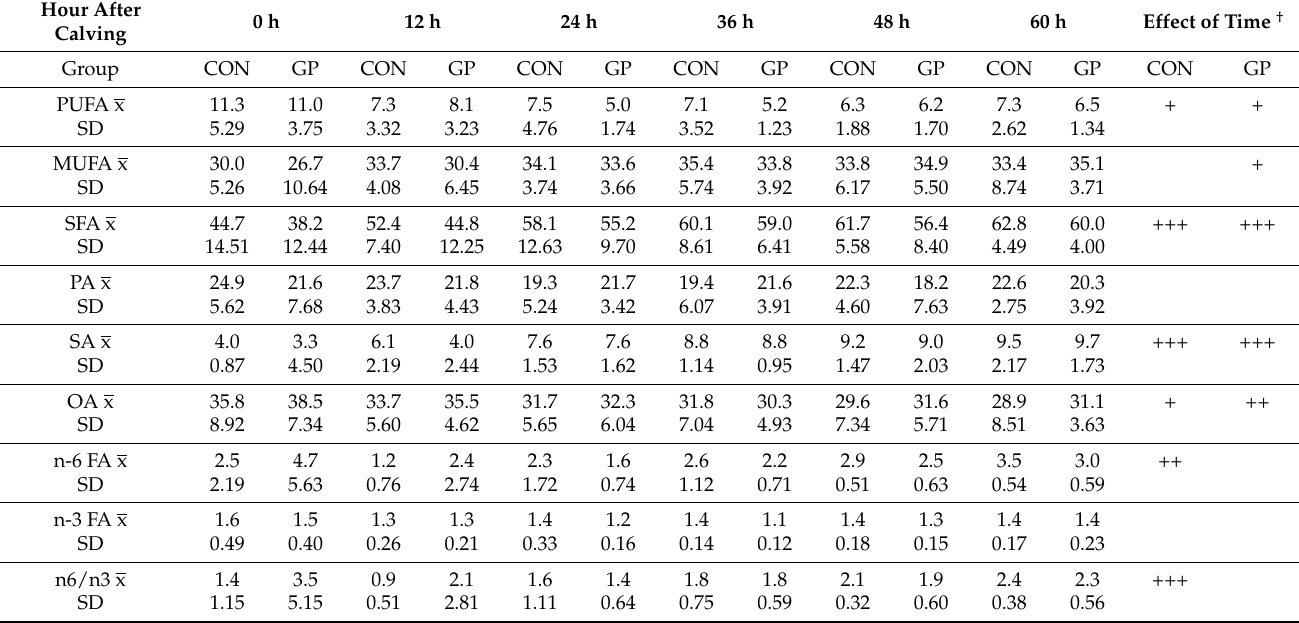
Table 3. The concentrations of fatty acids in the cow colostrum (g/100 g